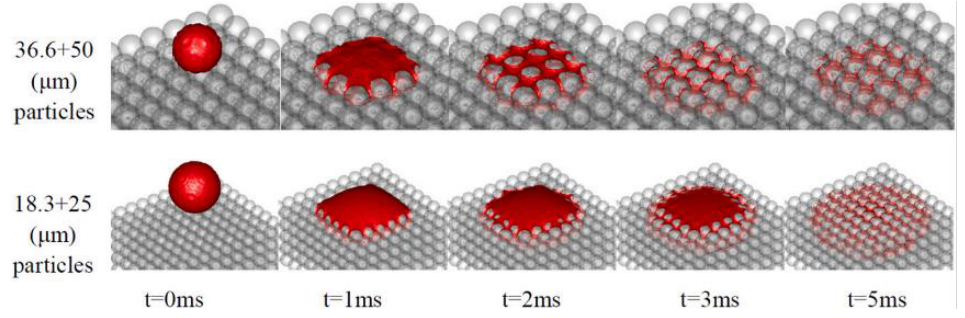
Figure 9. Droplet impact and penetration into the two types of powder beds [47].